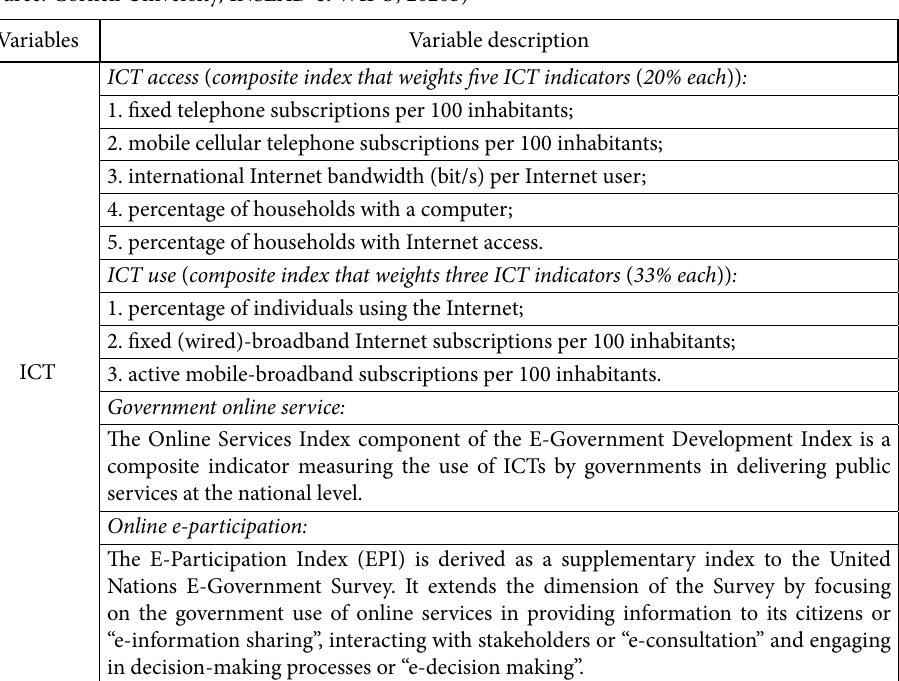
Table 1. Description of infrastructure innovation variables (source: Cornell University, INSEAD & WIPO, 2020b)